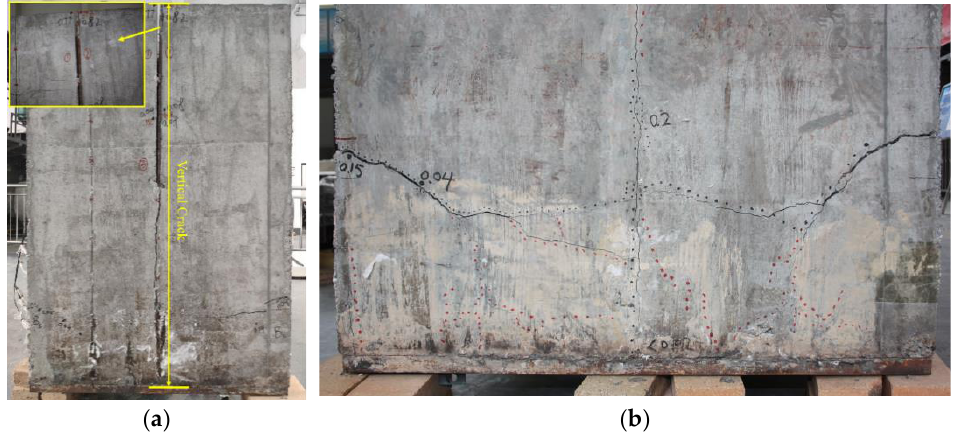
Figure 11. Cracks in the member without fire protection. ( a ) Vertical cracks; ( b ) transverse cracks.